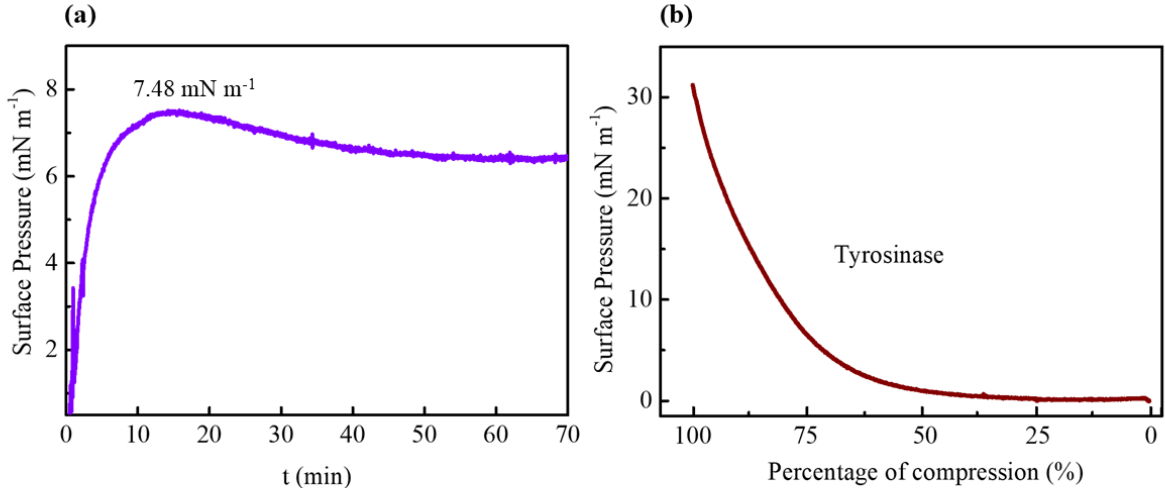
Figure 1. The kinetics of adsorption of 1.74 mg mL -1 Tyr injected into the PBS subphase ( a ). π-A isotherms recorded for pure Tyr at 1.74 mg mL -1 on the PBS subphase ( b ). The x-axis is given in percentage of compression since the amount of Tyr at the interface is